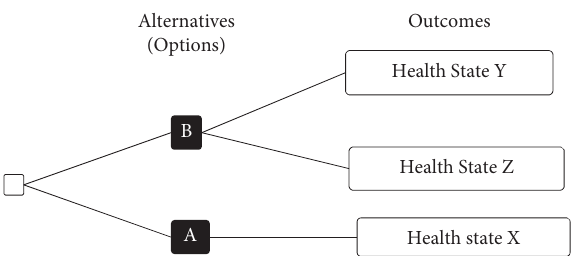
Figure 1: Standard gamble method for measuring health utility value